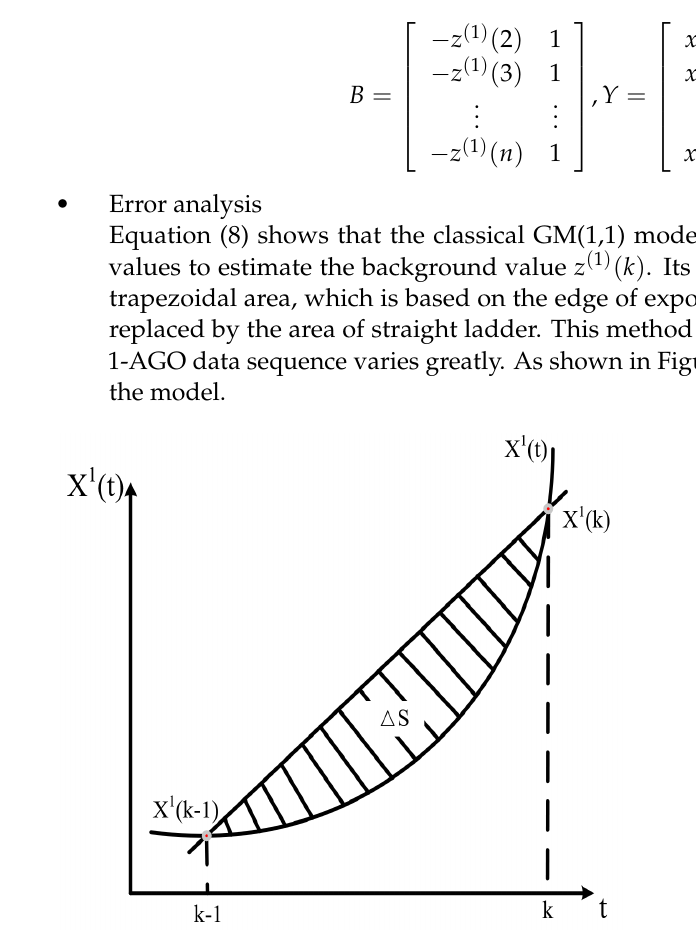
Figure 6. Reasons for GM(1,1) model